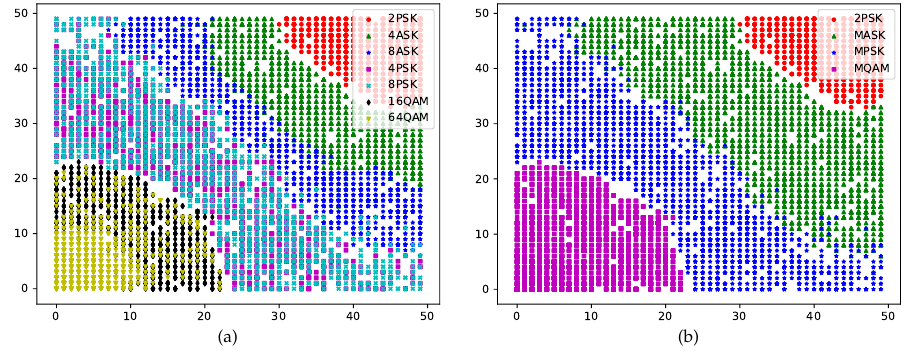
Figure 3. Clustering results in the root layer with different